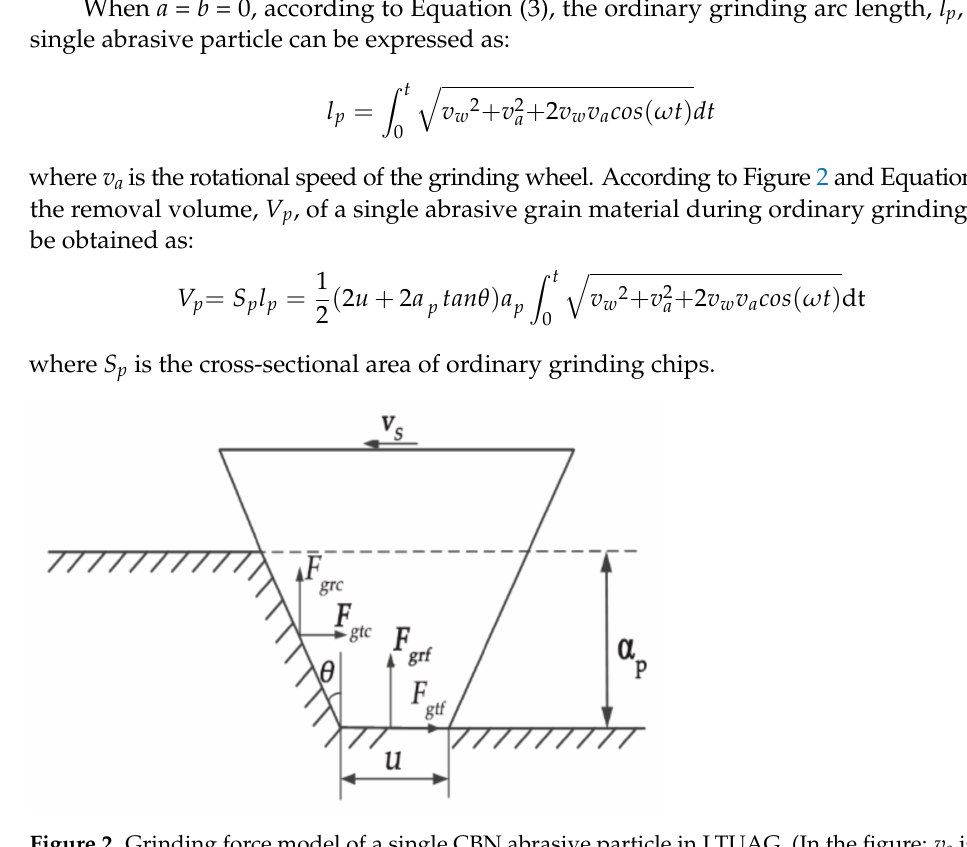
Figure 2. Grinding force model of a single CBN abrasive particle in LTUAG. (In the figure: v s is the grinding linear speed, a p is the grinding depth of a single abrasive particle in LTUAG, F gt c is the tangential deformation force for wear debris of a single abrasive particle, F gtf is the tangential friction of a single abrasive particle, F grc is the radial deformation force for wear debris of a single abrasive particle, F grf is the radial friction of a single abrasive